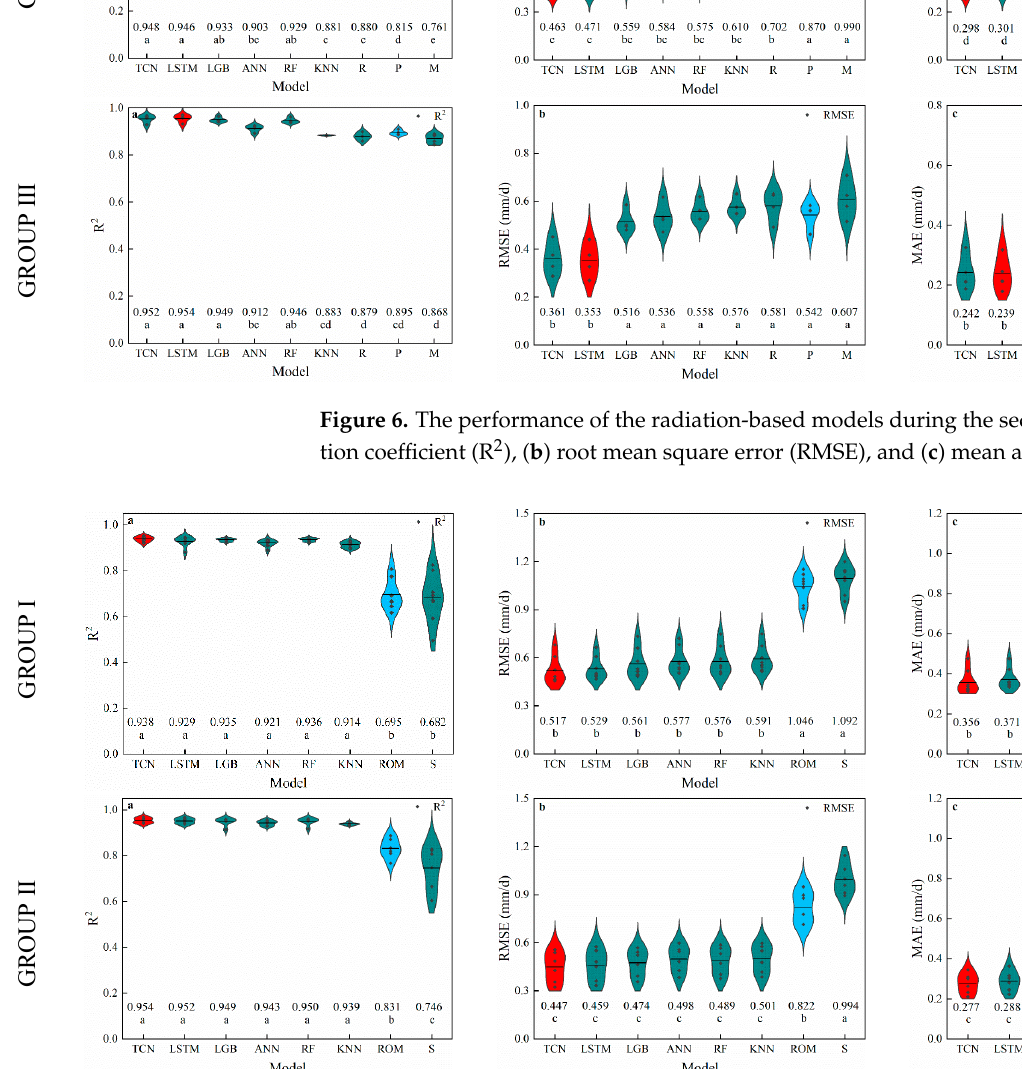
Figure 6. The performance of the radiation-based models during the second strategy: ( a ) determi- nation coefficient (R 2 ), ( b ) root mean square error (RMSE), and ( c ) mean absolute error (MAE).